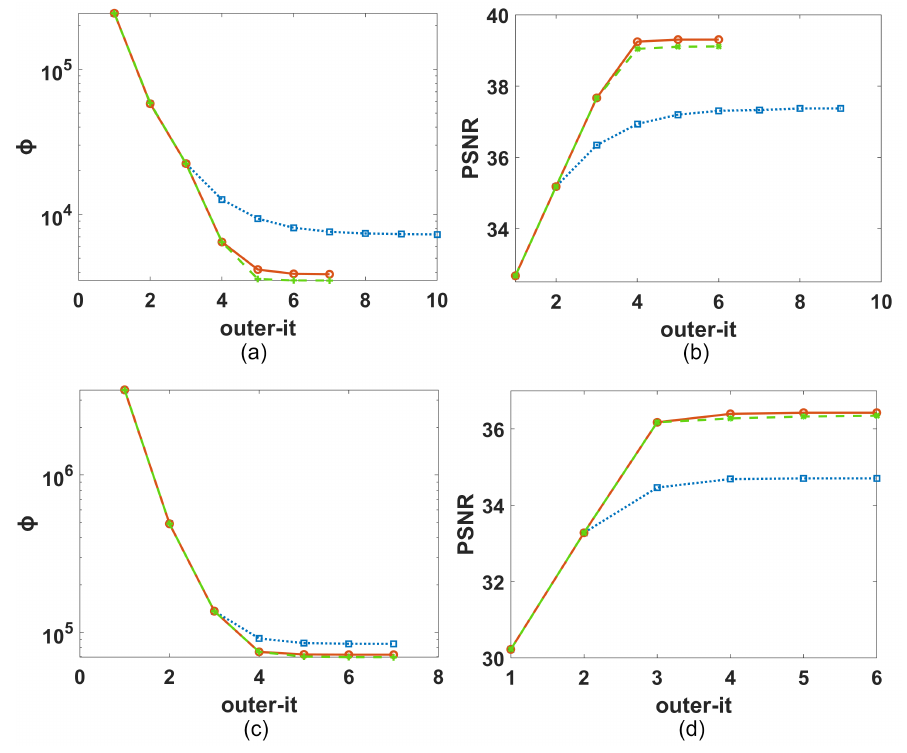
Figure 3. Comparison of ASRp results on SISR for p = 1 (blue dotted line), p = 2 (red continuous line), and p = 3 (green dashed line). On the left: Φ ( x k , λ k ) as a function of the outer iteration number for I1 ( a ) and I2 ( c ). On the right: PSNR values as a function of the outer iteration number ( outer-it ) for I1 ( b ) and I2 ( d